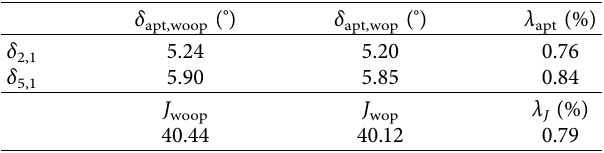
Figure 15: Power angle diference between SGs with and without optimization to K between #2 and #1 SGs. (b) Power-angle diference between #5 and #1 SGs. Table 11: Efect analysis of coordinated optimization to K of the CCC.